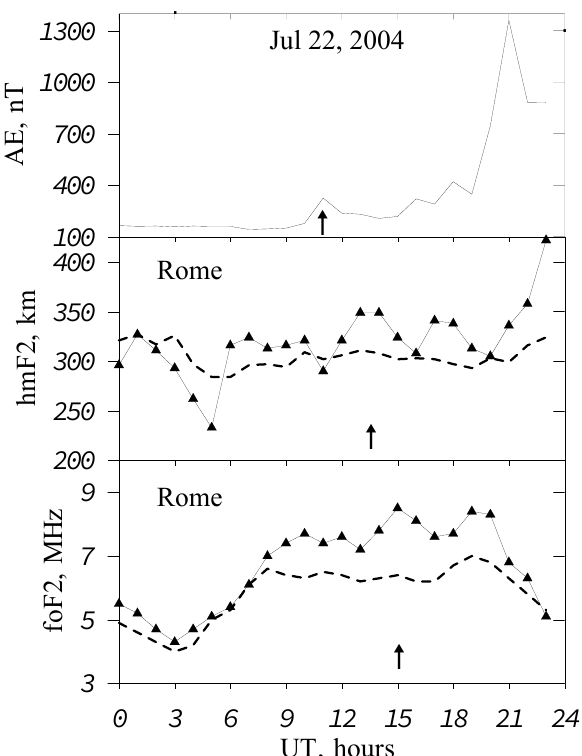
Fig. 5. Fig. 5. Observed variations of AE-index, hm F2, and fo F2 at Rome on 22 July 2004. The TAD was launched by the upsurge of the auroral activity around 11:00UT and its passage (arrows) is seen in hm F2 and Nm F2 variations at Rome around 14:00–15:00UT. Dashes – median